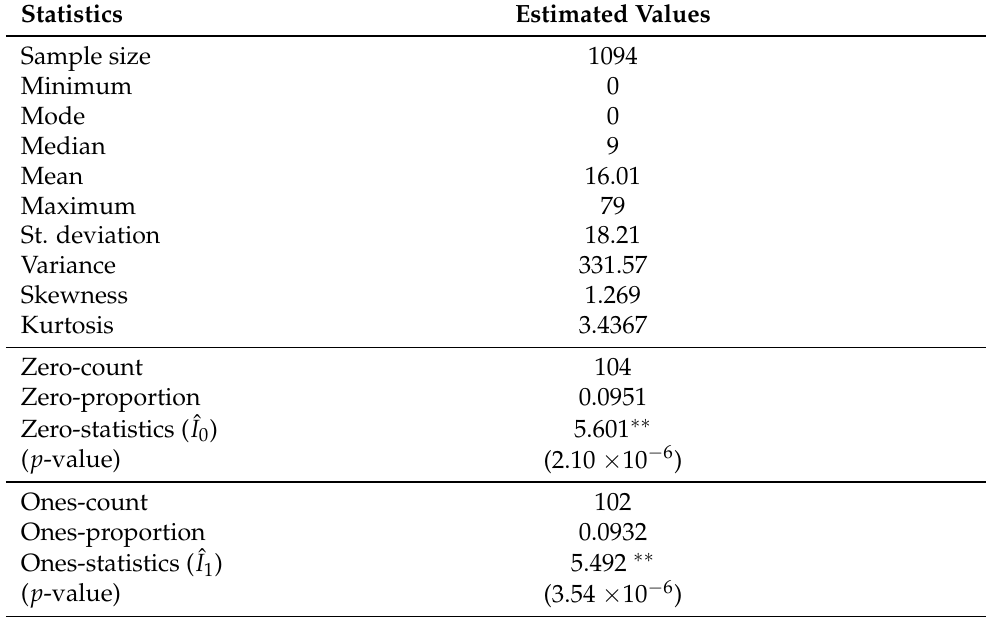
Table 3. Summary statistics of the number of deaths per day in the Republic of Serbia, with zero- and-one inflation